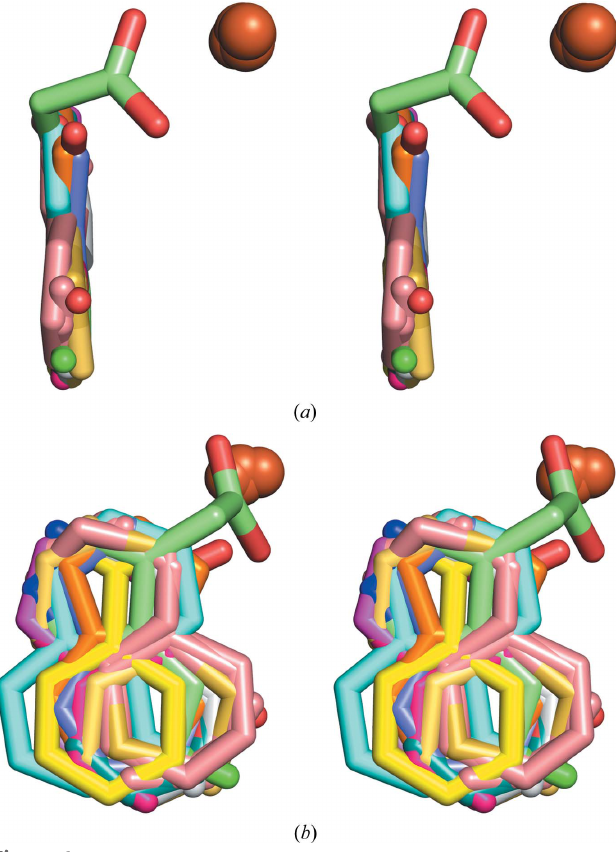
Figure 6 Stereo diagram of a superposition of all of the ligands discussed in the manuscript from two different views: ( a ) perpendicular to the plane of the aromatic rings and ( b ) parallel to the plane of the aromatic